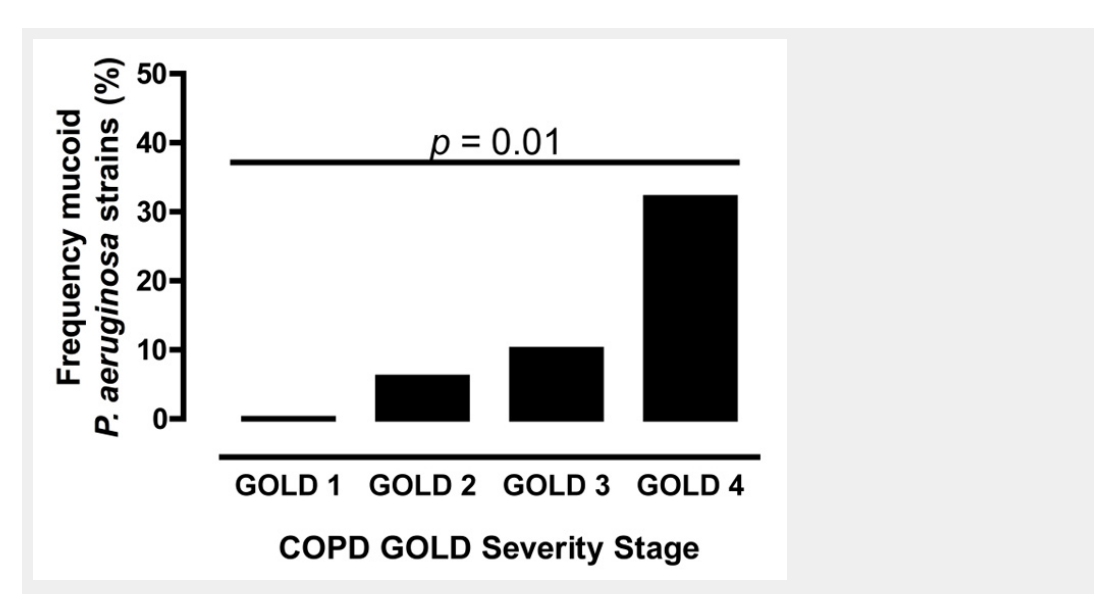
Figure 4 Frequency of mucoid phenotype in P. aeruginosa isolates from COPD patients stratified according to severity of disease (GOLD1-4). p -values were obtainedutilising the Chi-square